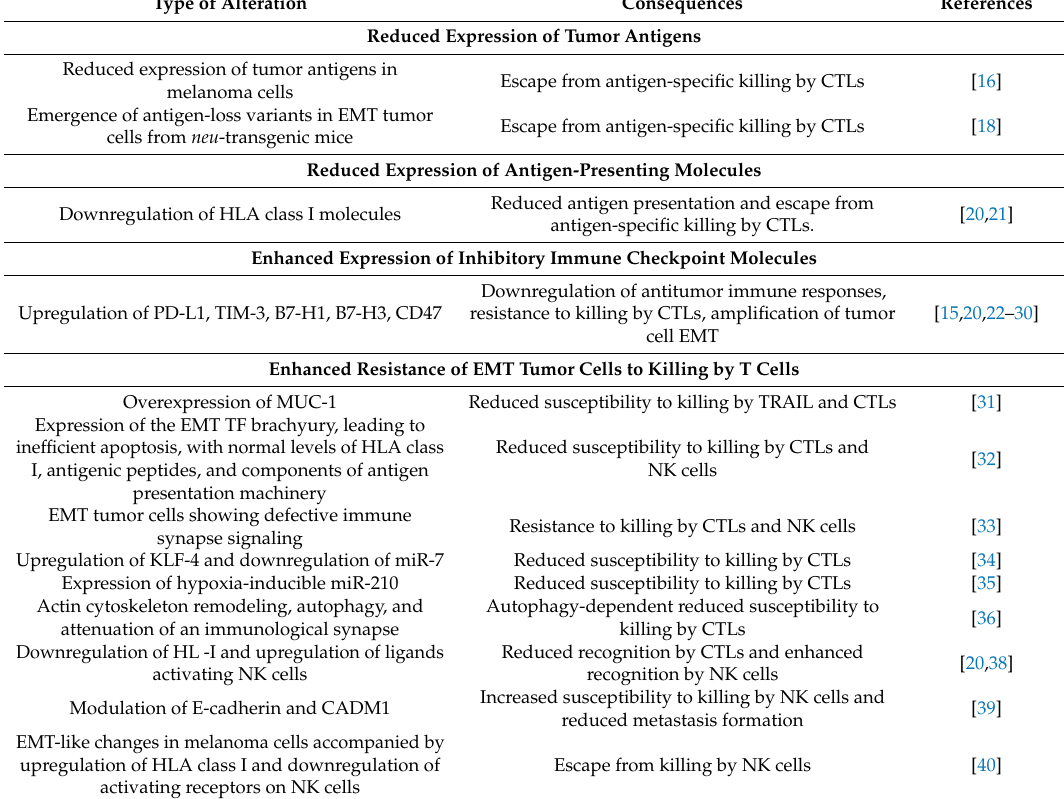
Table 1. Epithelial-mesenchymal transition (EMT)-associated changes in the immunological profile of tumor